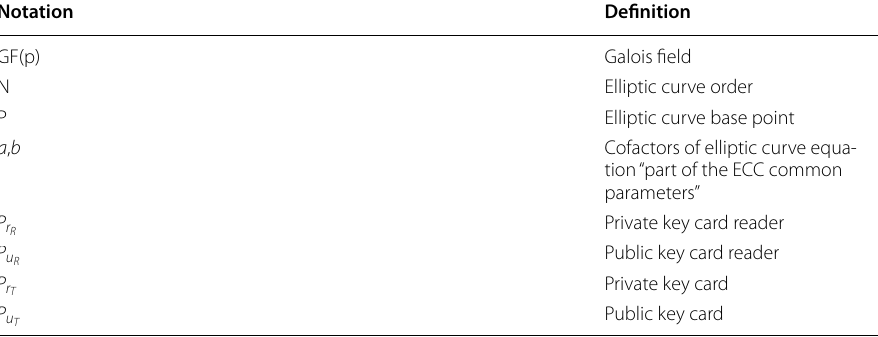
Table 1 Definition of notations used in the Alamr scheme [3]